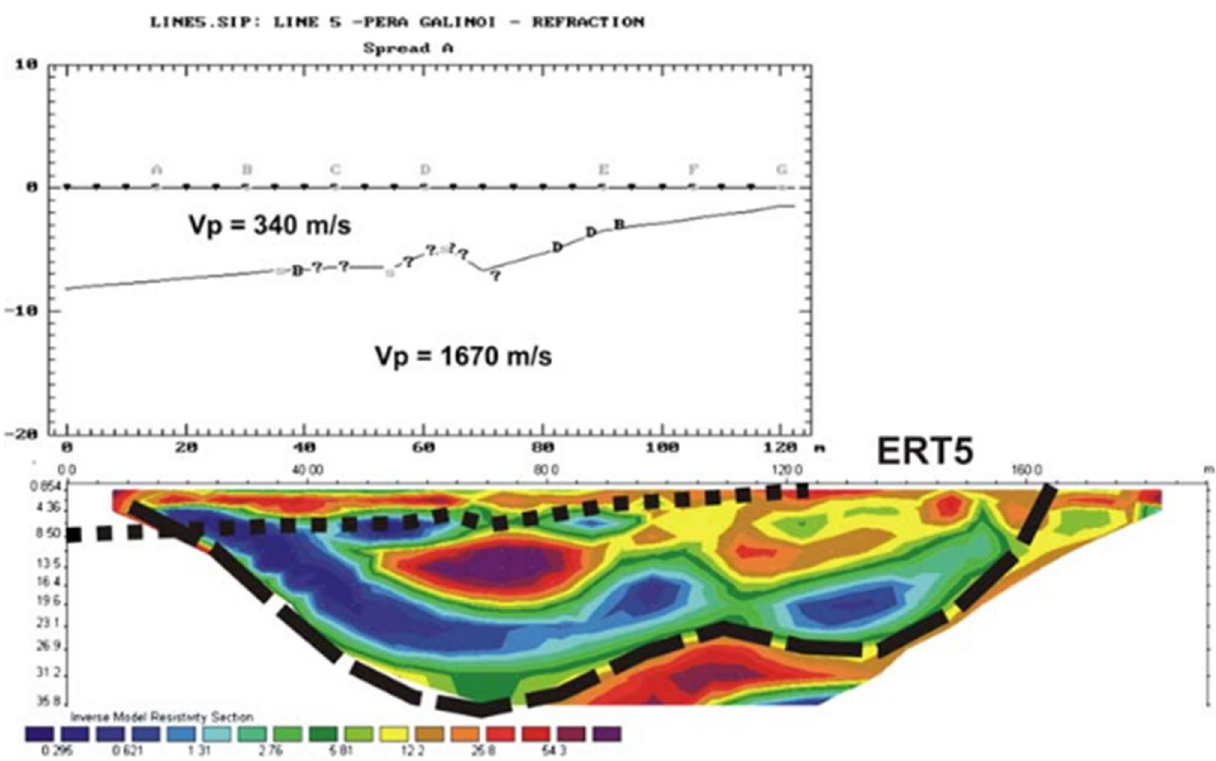
Fig. 4 Comparison of the refraction seismic (upper) and the geoelectrical tomography (lower) for the same profile after Soupios et al. (2007)